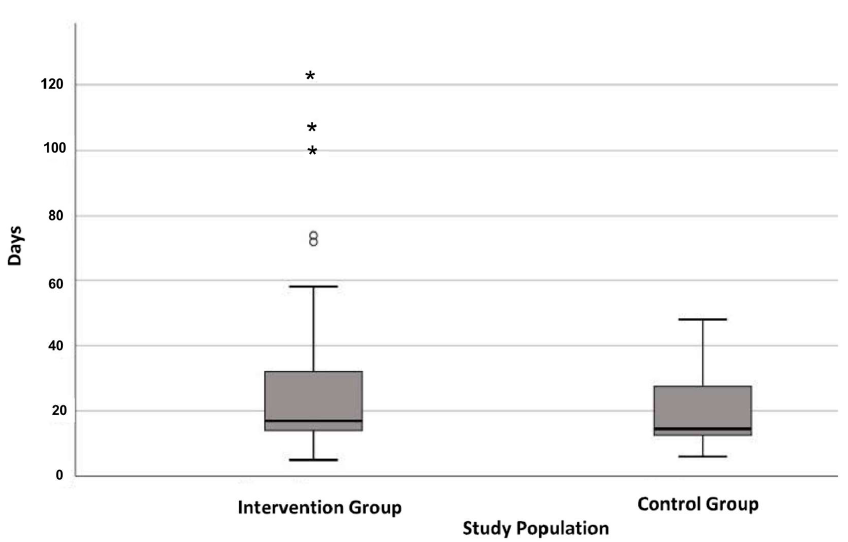
Figure 3. Boxplot on total length of hospital stay during surgery. ° outlier, * extreme outlier.